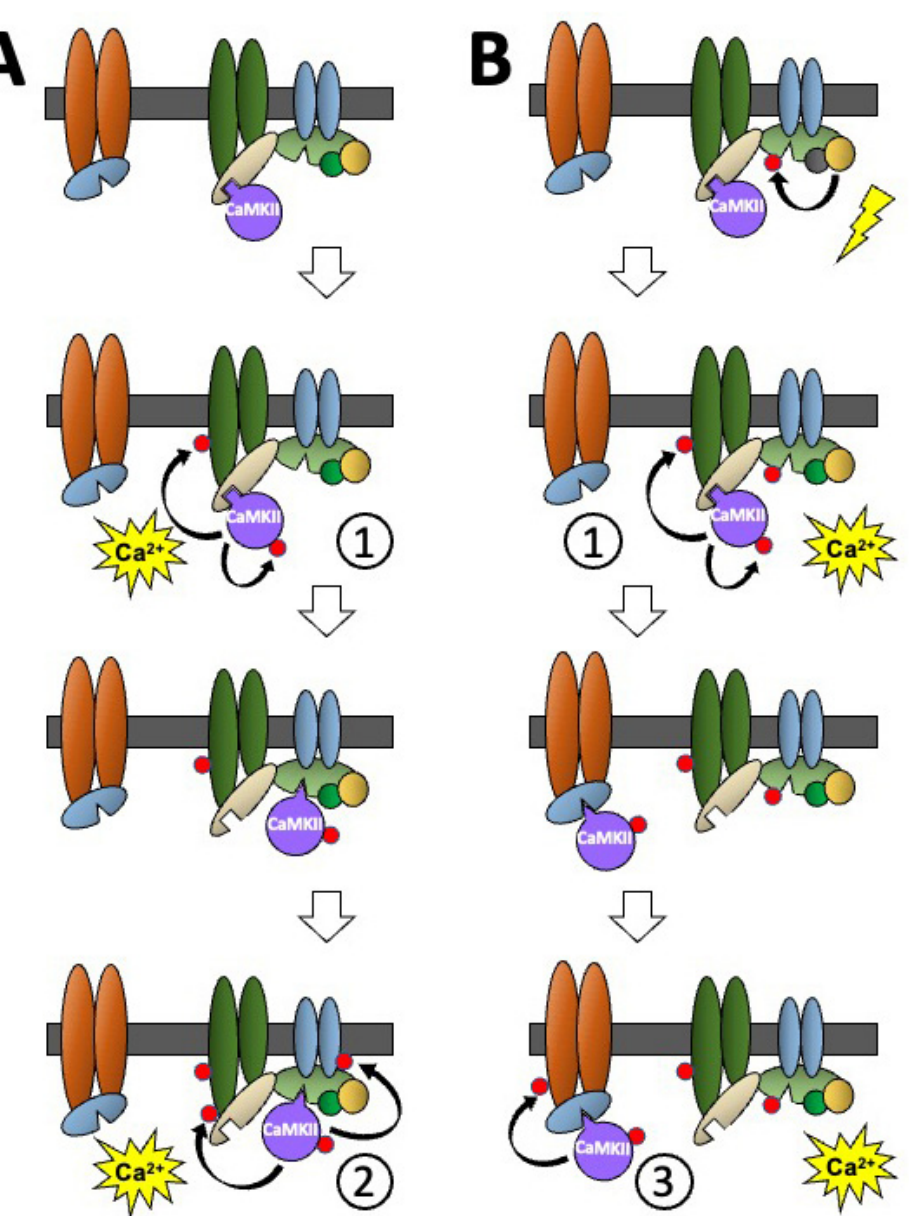
Figure 4. A schematic diagram showing how stimulus-induced translocation of CaMKII between different binding proteins in a molecular environment can produce different functional responses to the activation of CaMKII by two sequential stimuli of the same type and how the influence of another signalling pathway can further modify the CaMKII response. The effects of two sequential stimulus-induced rises in calcium on non-phosphorylated CaMKII, when the surrounding binding partners are ( A ) also non-phosphorylated, or ( B ) phosphorylated. Coloured oblong shapes represent generic proteins with which CaMKII (purple disc) binds directly or indirectly. Dark grey bar represents a membrane. Geometric protrusions from CaMKII, and indents in the binding proteins represent binding sites for CaMKII. The small red disc represents the phosphorylation of a protein. See text for explanation of the sequence of events shown in the Figure.